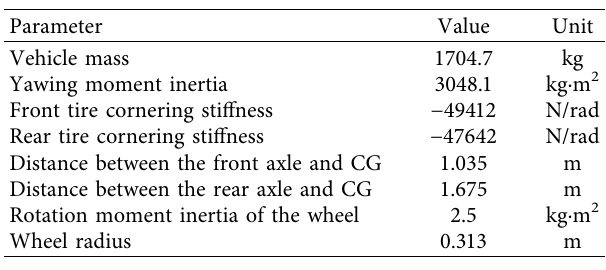
Table 1: Vehicle parameters.